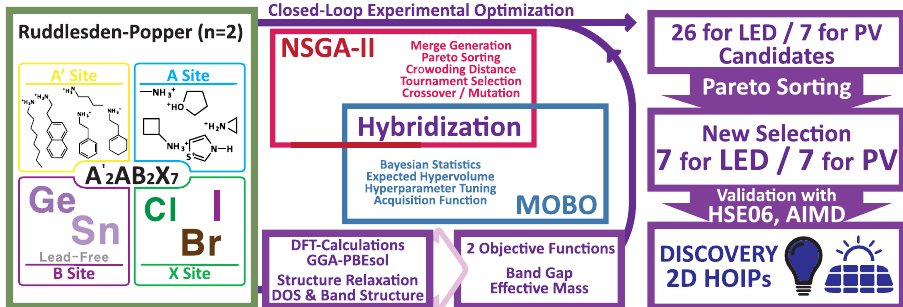
Fig. 2 Schematic representation of the entire computational process involving the DFT-calculated-data-based NSGA-II/MOBO process. The search space based on the RP structure ( n = 2) is schematically summarized on the leftmost side. The hybridized NSGA-II and MOBO algorithm are shown in the middle. All the operators for NSGA-II and MOBO are listed in the box. The NSGA-II/MOBO process led to 24 HOIP candidates for LEDs, which were reduced to seven candidates with stricter selection criterion, and in parallel, seven candidates for solar cell applications were directly selected from the NSGA-II/MOBO